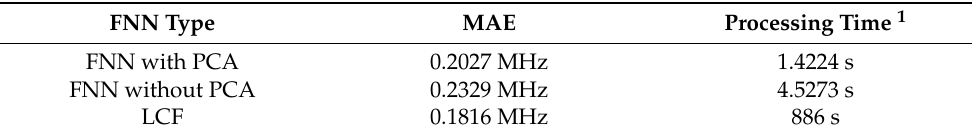
Table 3. Details of the comparison between FNN with PCA and FNN without PCA.